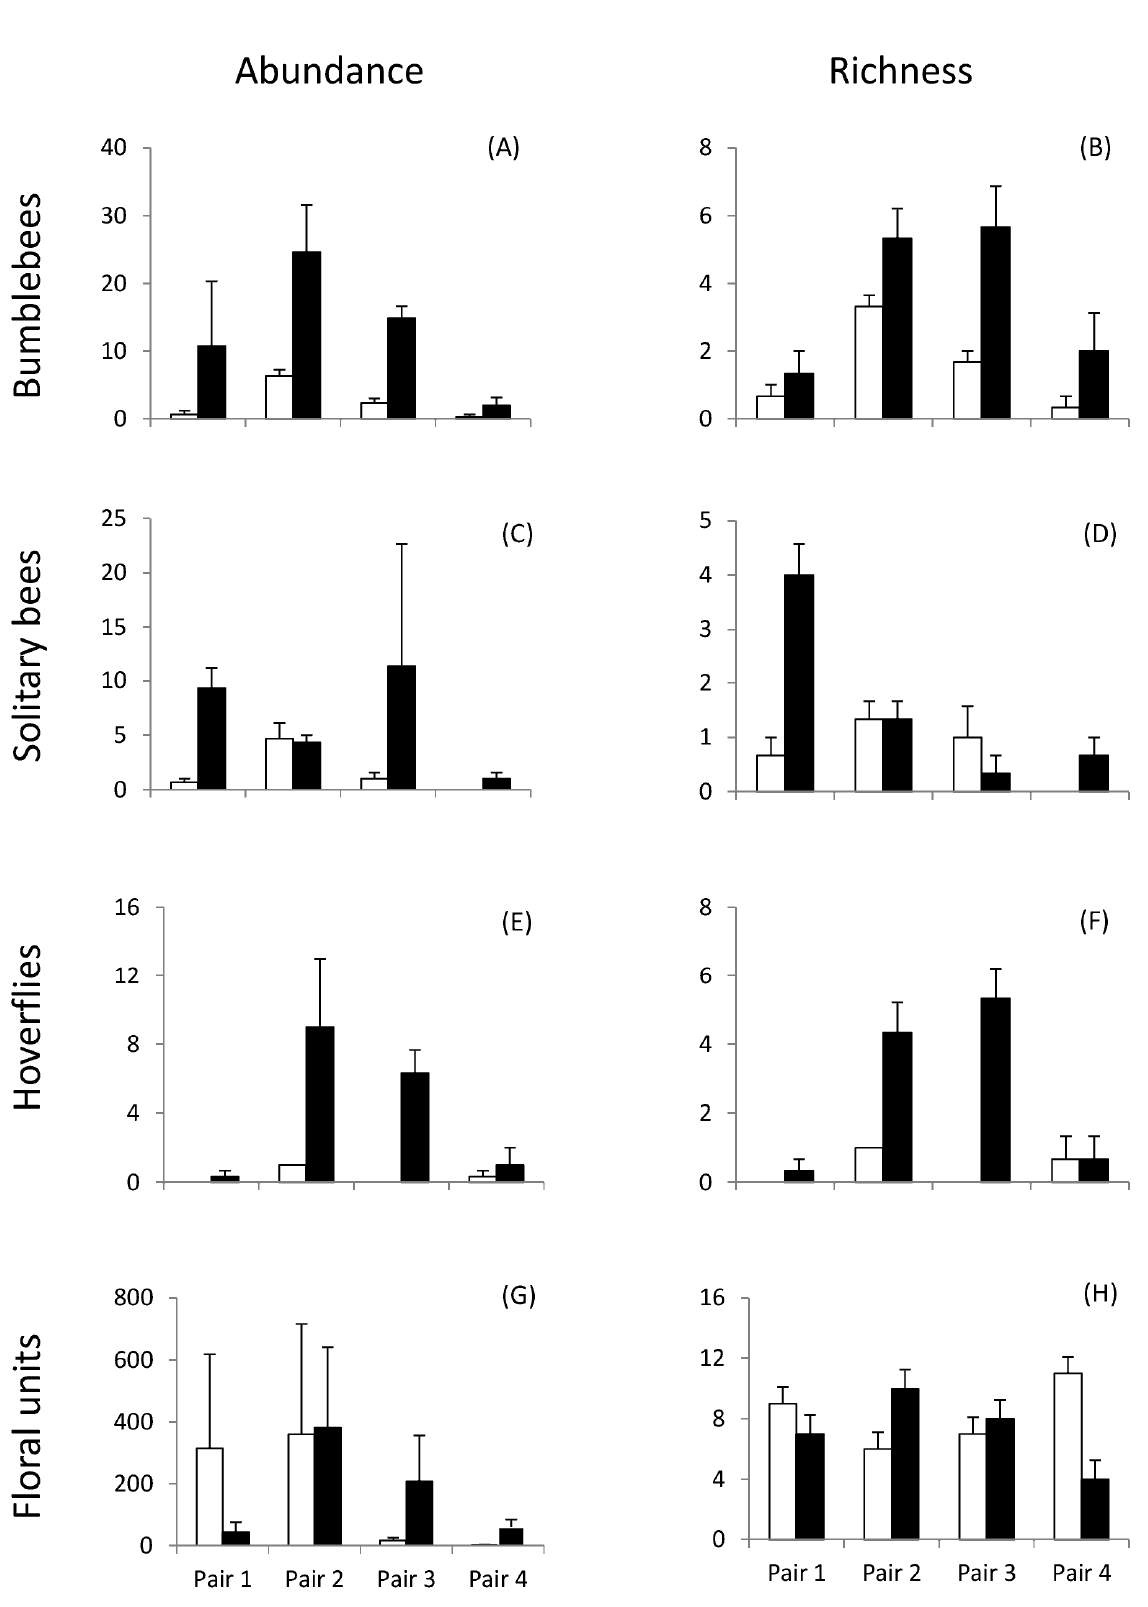
F IGURE 7. (A-H) Mean abundance and richness (± standard error) of each taxonomic group based on treatment ( S. repens vs. no S. repens ). Pair 1 = Arklow; Kilpatrick, pair 2 = Magherabeg; Brittas pair 3 = Ballyteige; Raven Point, pair 4 = Courtown; Cahore. Empty bars = absent, filled bars = S. repens present; richness here means number of species occurring.